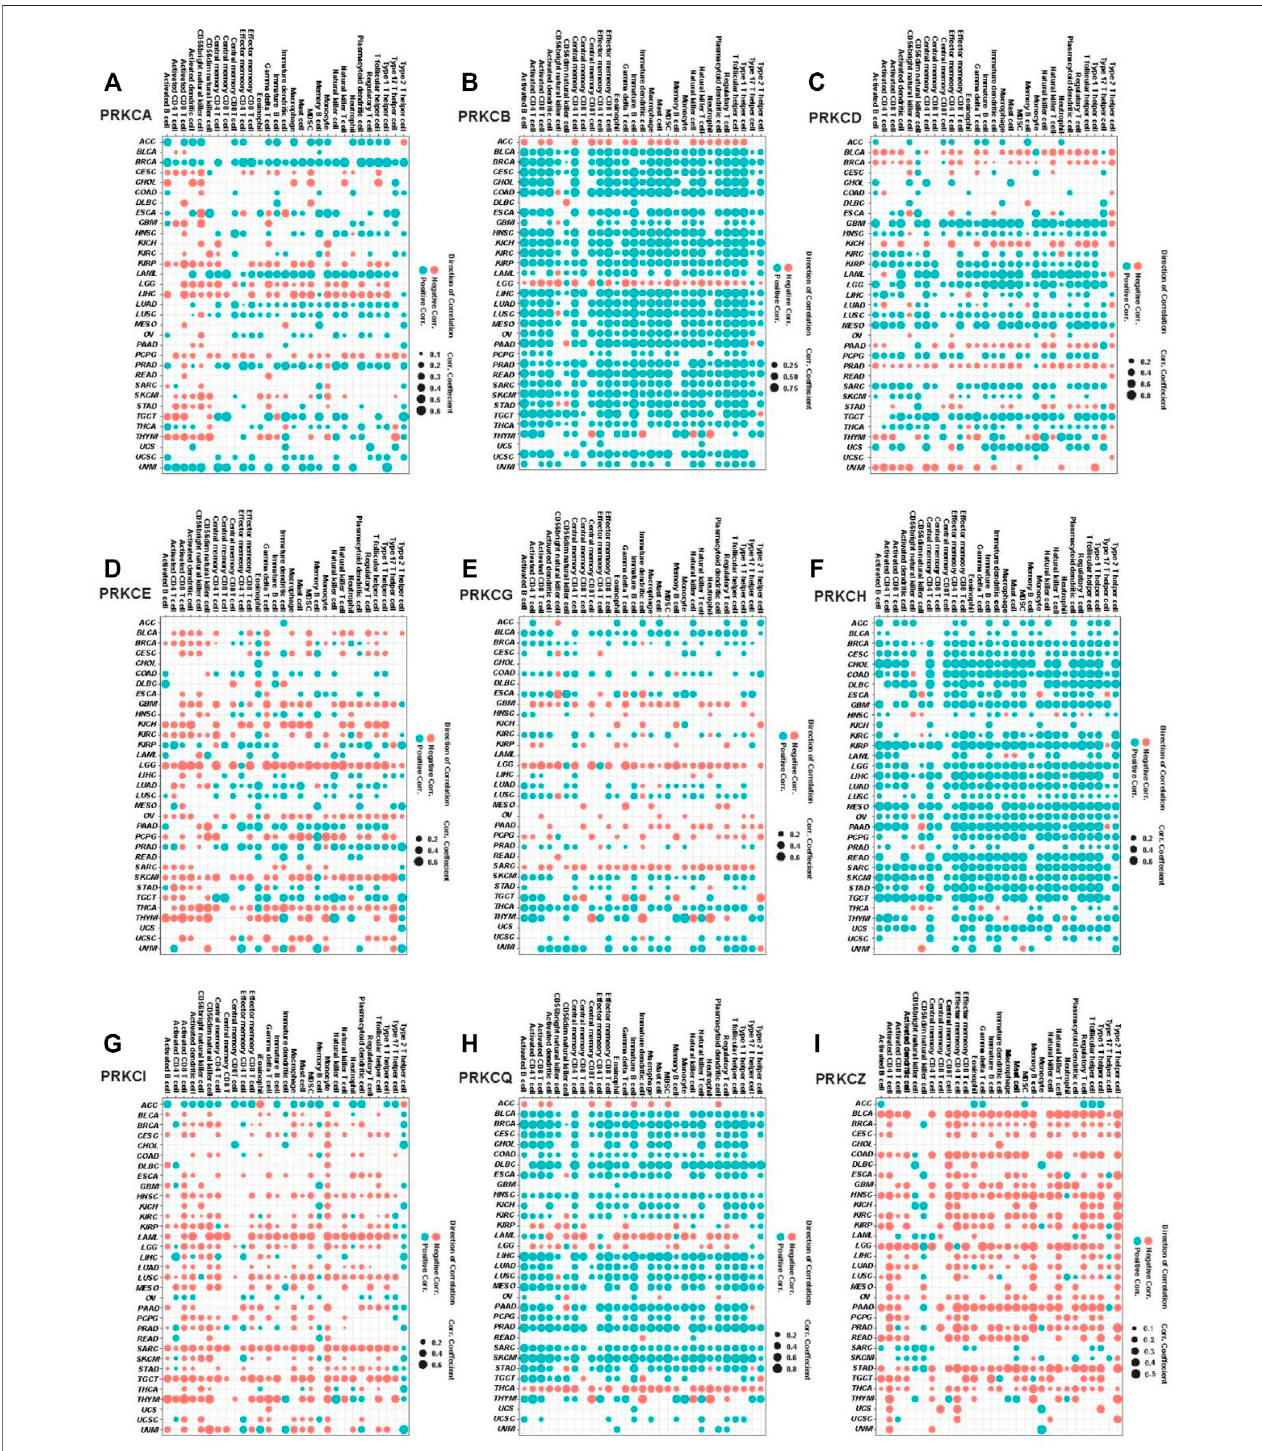
FIGURE 7 | Pan-cancer analysis for the signi fi cant correlation between PKC genes expressions and ssGSEA scores of 28 immune cell subpopulations; PRKCA (A) , PRKCB (B) , PRKCD (C) , PRKCE (D) , PRKCG (E) , PRKCH (F) , PRKCI (G) , PRKCQ (H) , PRKCZ (I) . The dot size states the correlation coef fi cients, while the color refers to the direction of the correlation, blue (cid:1) positive correlation, and red (cid:1) negative correlation ( p -value < 0.05).